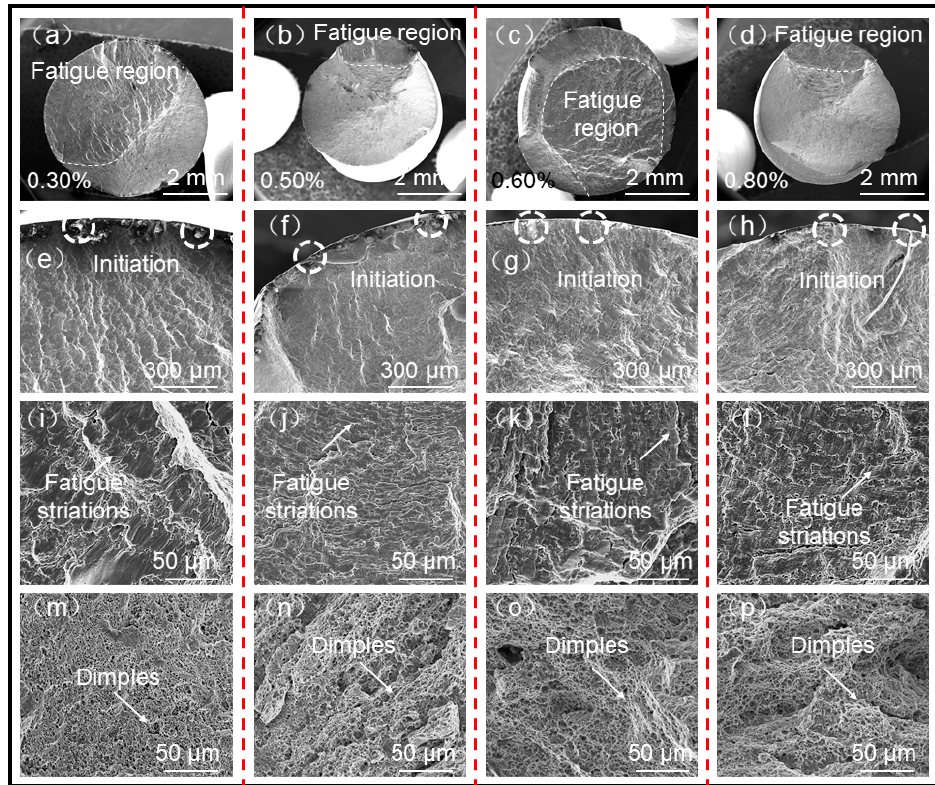
Figure 9. Low-cycle fatigue fractures of SAAM high-strength low-alloy steel workpieces under different strain amplitudes ( a – d ) are the macro fracture morphologies under different strain amplitudes respectively. ( e – h ) are fatigue crack initiation zones under different strain amplitudes respectively. ( i – l ) are the fatigue crack growth zones under different strain amplitudes respectively. ( m – p ) are the fracture zones under different strain amplitudes respectively).